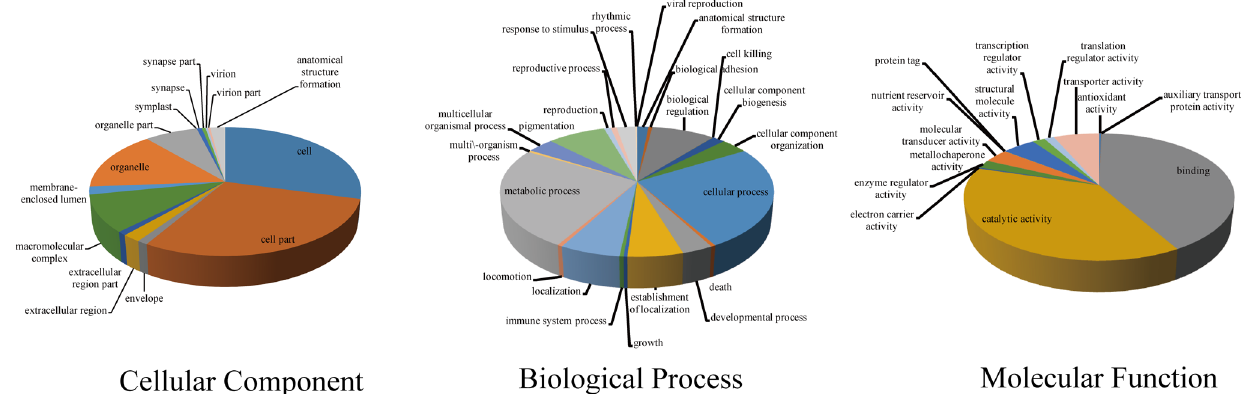
Fig 3. Gene ontology (GO) assignment for the Pieris rapae transcriptome. GO assignments for predicted for their involvement in pie charts (A) biological processes, (B) cellular components, and (C) molecular function.